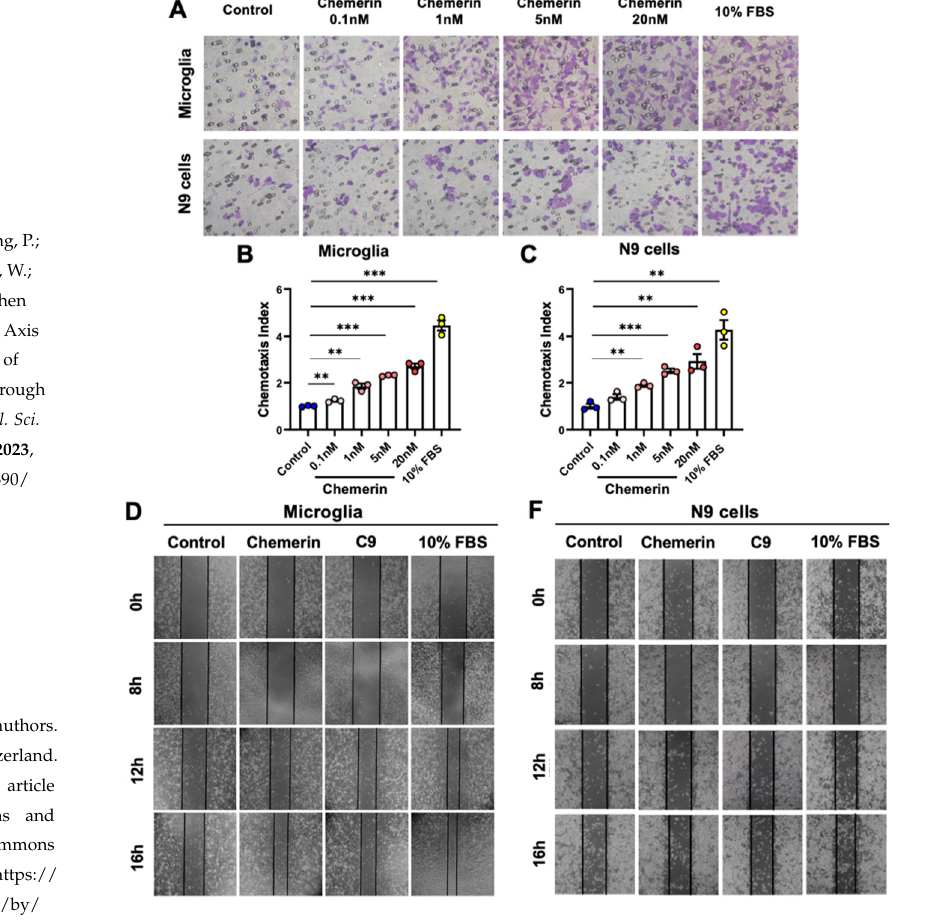
Figure 3. Chemerin/CMKLR1 axis promotes the migration of microglia in Boyden chamber migra- tion and scratch-wound assay. ( A ) Primary cultures of microglia and murine microglial N9 cells were incubated for 12 h with chemerin (0.1–20 nM) or 10% FBS, and the migration of the cells was evaluated by 48-well chemotaxis chambers. Representative images of migrated cells on membrane filters are shown. ( B , C ) The Quantified data are shown. Magnification, ×400. Primary microglia and N9 cells were treated with chemerin (5 nM), C9 (100 nM), or 10% FBS; then, the migration of the cells was detected by scratch-wound assay. The microglia were photographed at 0 h, 8 h, 12 h, and 16 h. Representative images of migrated primary microglia and N9 cells are shown in ( D , F ), and